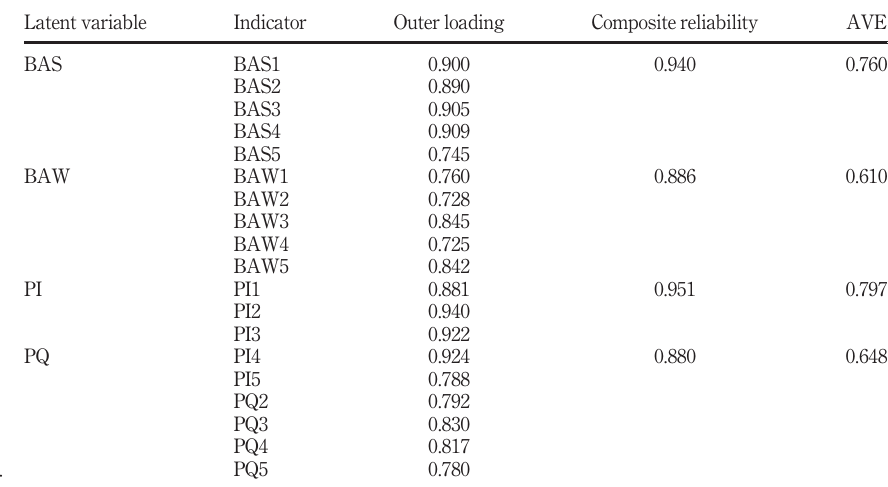
Table 2. Combined results for